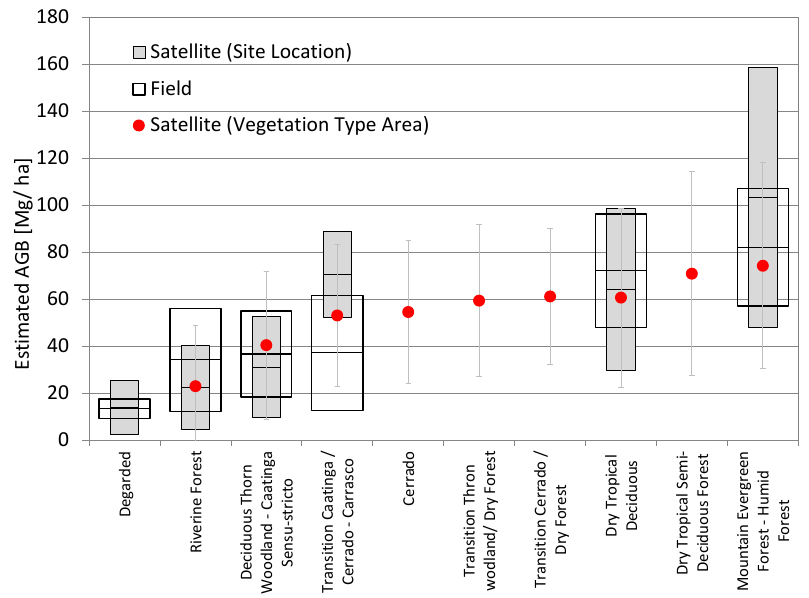
Figure 5. Average AGB grouped by the physiognomy classification map (Figure 1). The white boxes represent the average of field data AGB located within each of the physiognomy; the gray boxes represent the average satellites AGB estimates in 500m radius around the field plot locations, within each physiognomy. The boxes center represents the mean value, while the lengths represent plus and minus one standard deviation. Red dots represent the mean and respective standard deviation (light gray bars) of the satellite AGB averaged within the entire shapes defined by the physiognomy map (Figure